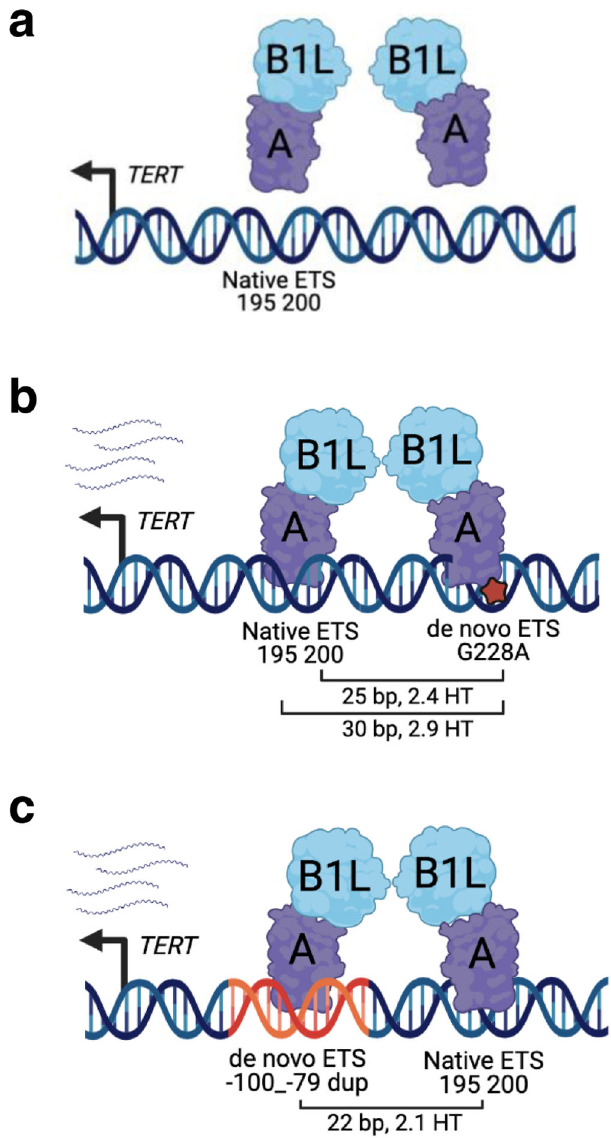
Fig. 6 | TERT promoter duplications mimic hotspot mutations for GABP tet- ramer recruitment. a Schematic of the wildtype TERT p. The native ETS motif is shown relative to the TERT ATG translational start site. GABPB1L-GABPA hetero- dimer is not bound to the native ETS motif and an inactive TERT p. b Schematic of the TERT p with a hotspot mutation. The native ETS motif and de novo ETS motifs (hotspot mutation) are shown relative to the TERT ATG. Distance in base pair (bp) between the native ETS motif and de novo motifs (hotspot mutation) is shown along with the associated helical turns (HT). GABPB1L-GABPA tetramer binding to the native ETS motif and de novo ETS motif (G228A, hotspot mutation) to activate the TERT p. c Schematicofthe TERT pduplication.NativeETSmotifanddenovoETS motif (c. − 100_ − 79, duplication) are shown relative to the TERT ATG. Distance (bp) between the native ETS motif and de novo ETS motif (duplication) is shown along with the associated helical turns (HT). GABPB1L-GABPA tetramer binding to the native ETS motif and de novo ETS motif (c. − 100_ − 79, duplication) to activate the TERT p. The fi gures were created with BioRender ( a – c